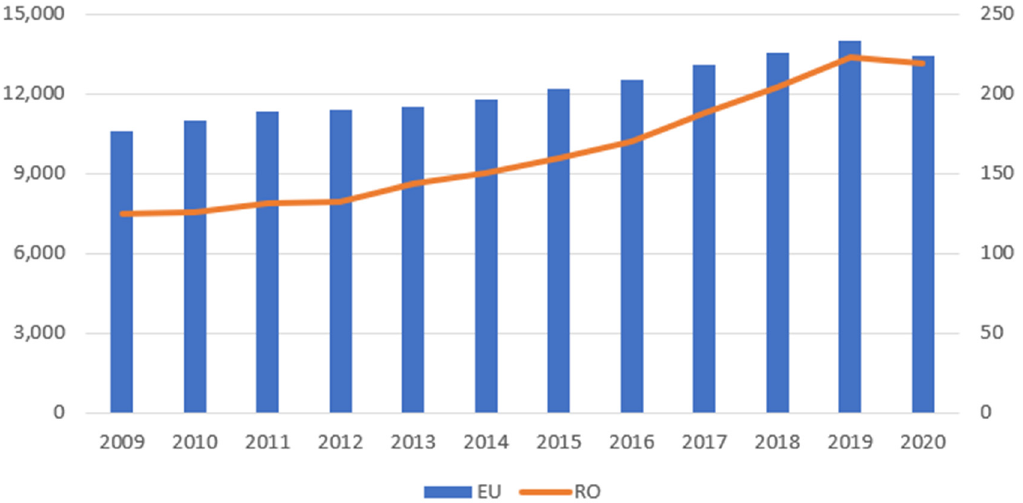
Figure 1. The evolution of GDP (billion euro) at the level of the EU and Romania from 1995 to 2020.